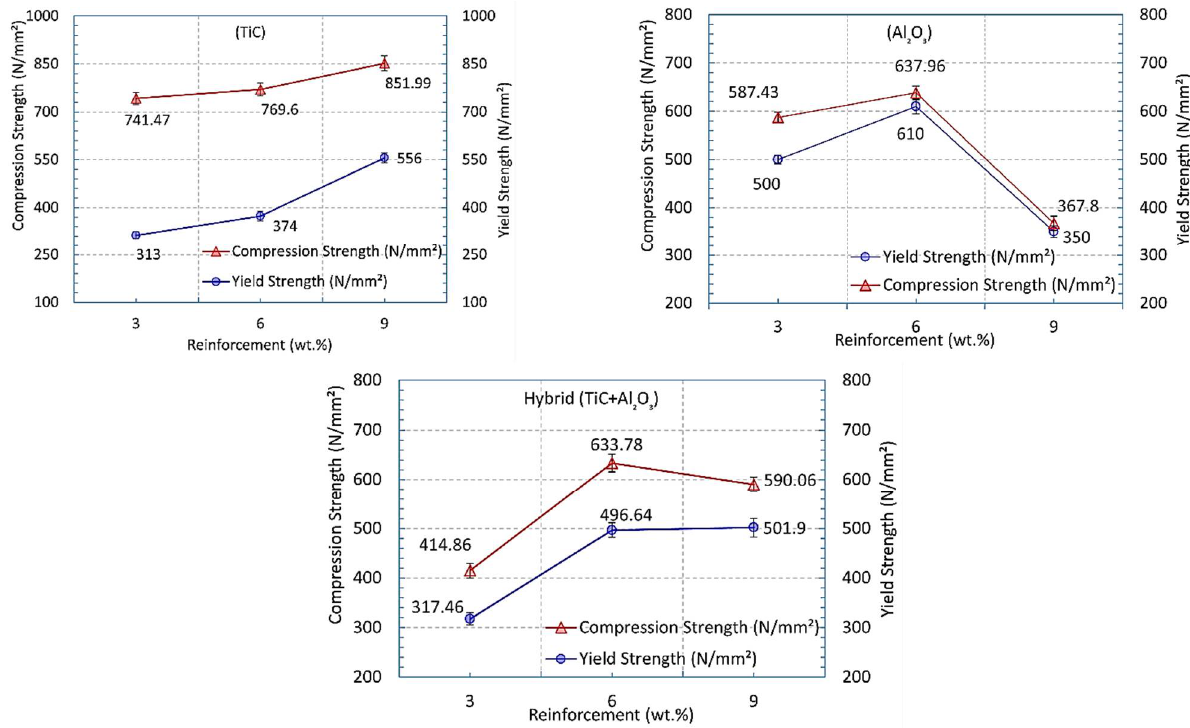
Figure 8. Compressive stress–strain curve for pure Cu and Cu-reinforced composites prepared by the spark plasma sintering route, ( a ) Cu/TiC composites, ( b ) Cu/Al 2 O 3 composites, and ( c ) Cu/hybrid composite.